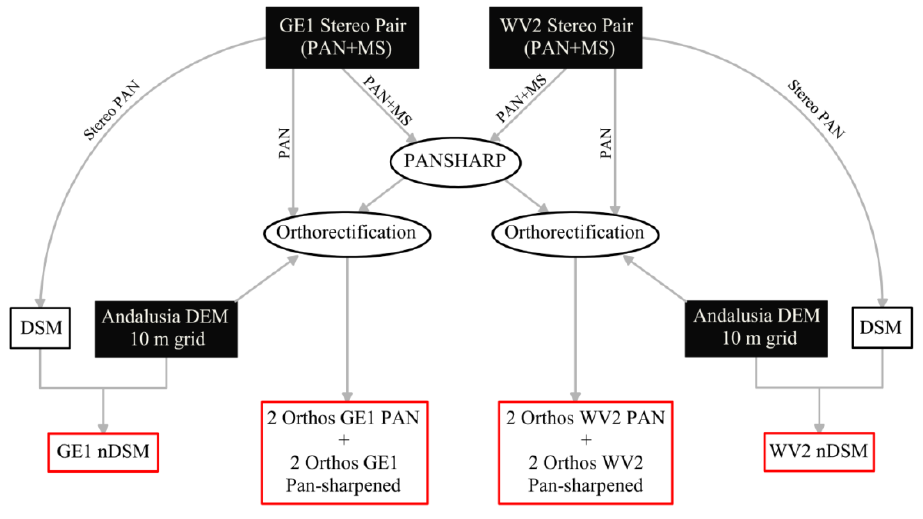
Figure 3. Flowchart regarding the pre-processing stage of data sets used in this